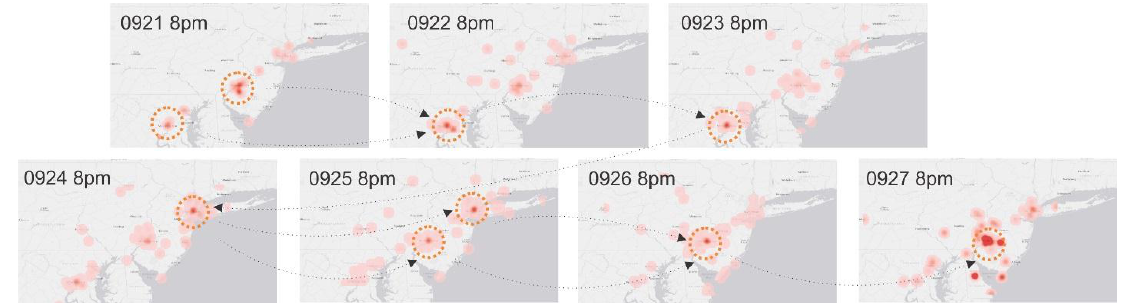
Figure 8. Spatial movement of tweet hotspots during the time Pope Francis visit US.